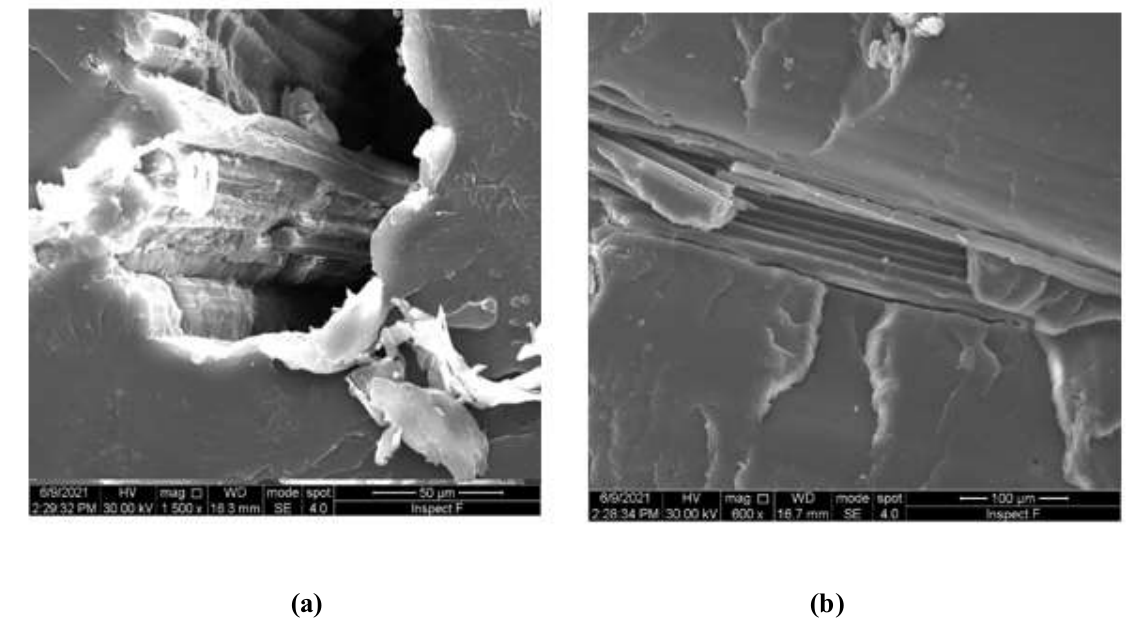
Figure 9: FE-SEM image of fractured surface morphology of PMMA reinforced with 5% wt of sisal fibers with